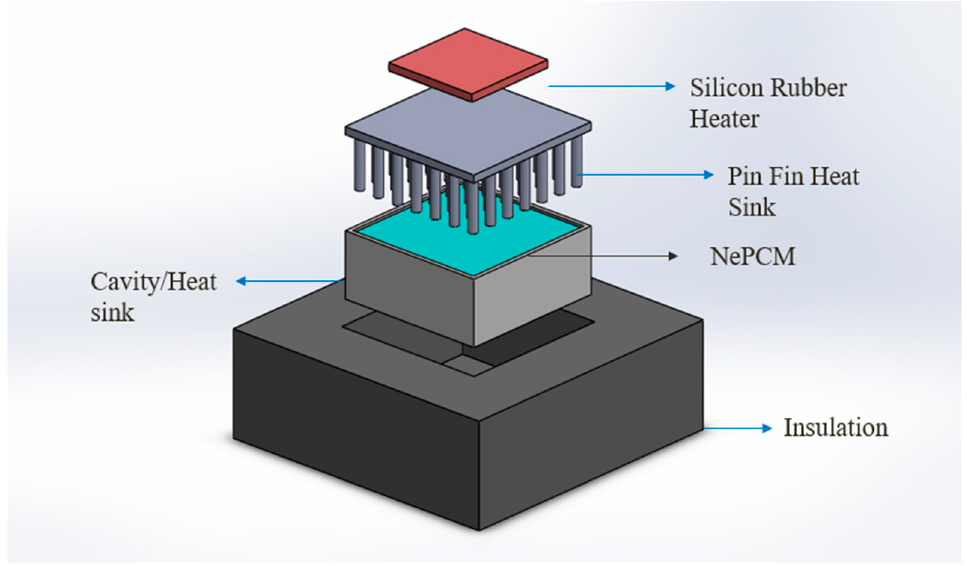
Figure 4. Exploded view of heat sink assembly.